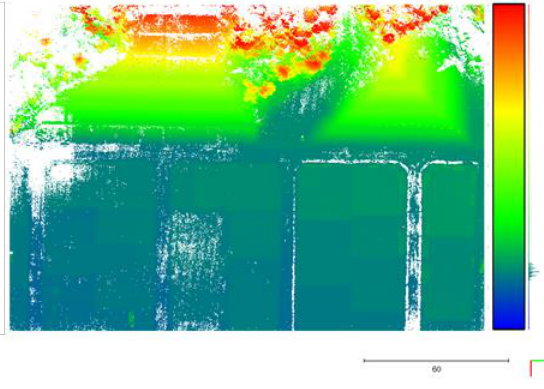
Figure 3. Tint map of laser